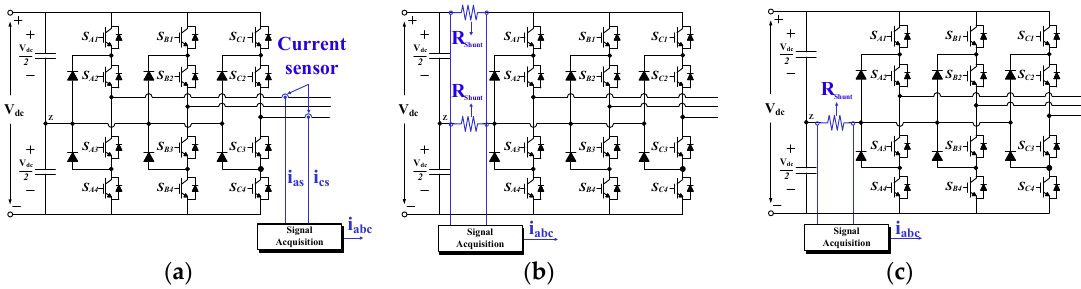
Figure 2. Measurement methods of phase current. ( a ) Conventional phase current sensing inverter (PCSI); ( b ) multi-shunt inverter (MSI); ( c ) neutral point clamped inverter (NPCI).